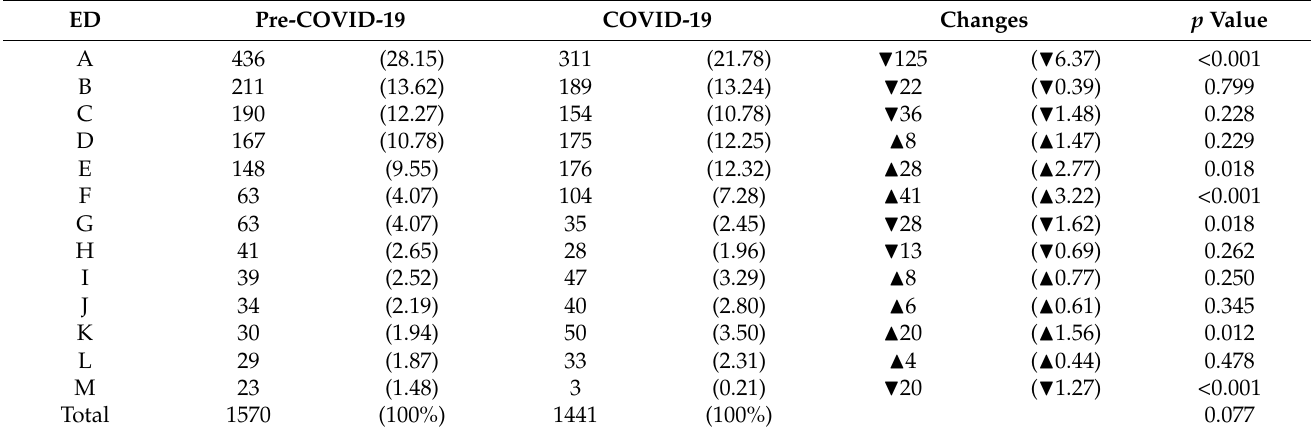
Table 2. Comparison of the number of patients with acute stroke symptoms using EMS who were transferred to EDs before and during